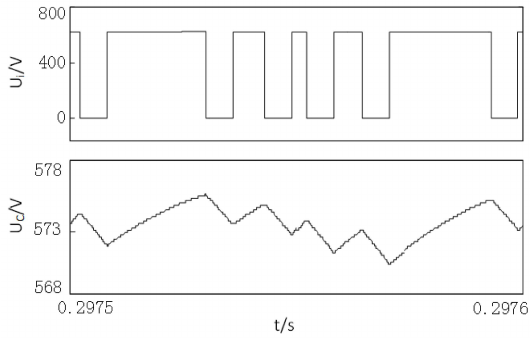
Figure 11. Amplified waveforms of the input voltage of the inverter bridge and the Z-source capacitor voltage corresponding to Figure 10.